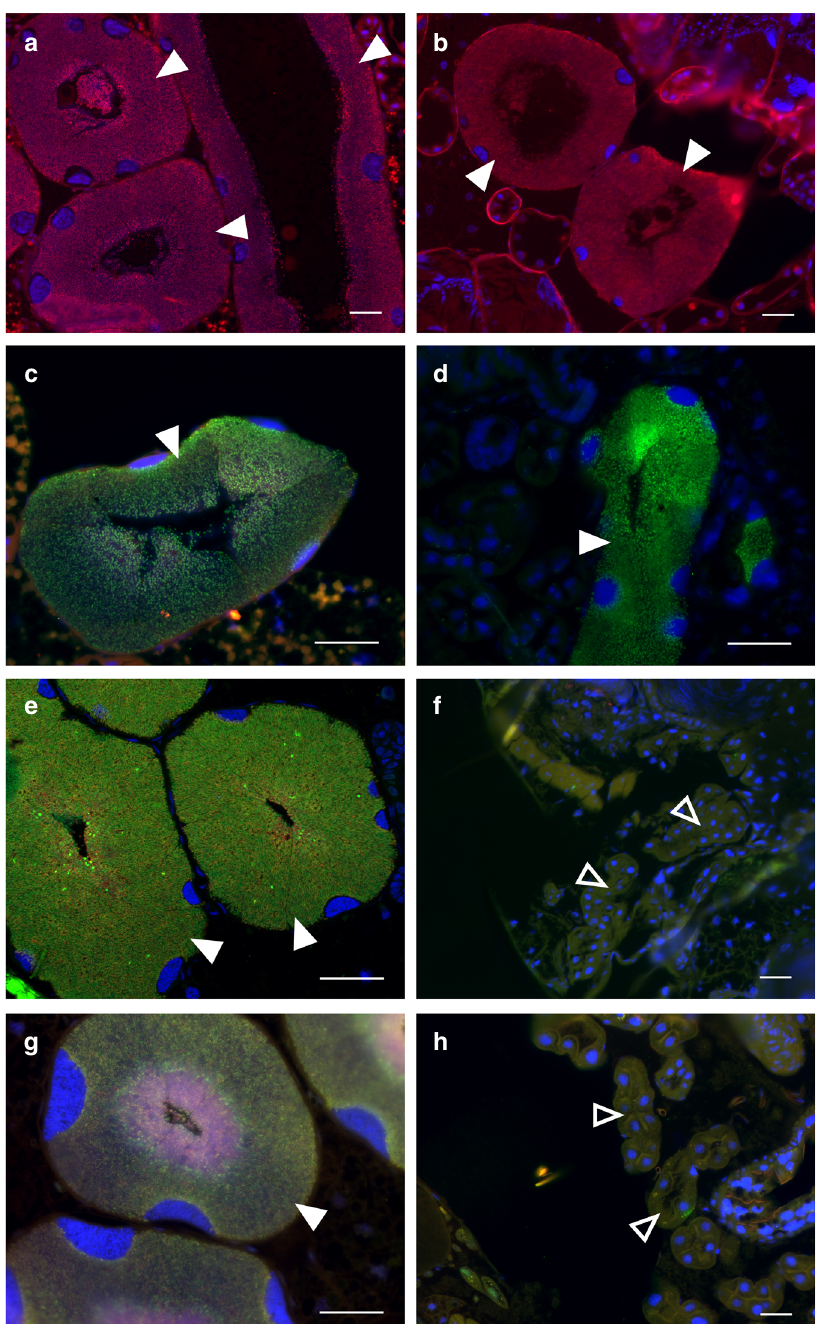
Fig. 7 Fluorescence in situ hybridization micrographs of symbiotic organs in Donaciinae. Females (left panel) and males (right panel) of four representative species feeding on different host plants are shown (for fl uorescence micrographs of 11 different species, see Supplementary Fig. 8). Note that different probes were used (see Supplementary Table 2), so the symbionts of different species are labeled in red (Cy3, a , b ), green (Cy5, c – e ), or yellow (Cy3 and Cy5, g ). DAPI (blue) was used for general DNA counterstaining. Filled white arrowheads highlight symbiont- fi lled Malpighian tubules (symbiotic organs), empty arrowheads point to Malpighian tubules without symbionts. The following species are shown (host plant order given in brackets): a , b Donacia crassipes (Nymphaeales), c , d Donacia dentata (Alismatales), e , f Donacia semicuprea (Poales), g , h Plateumaris sericea (Poales).